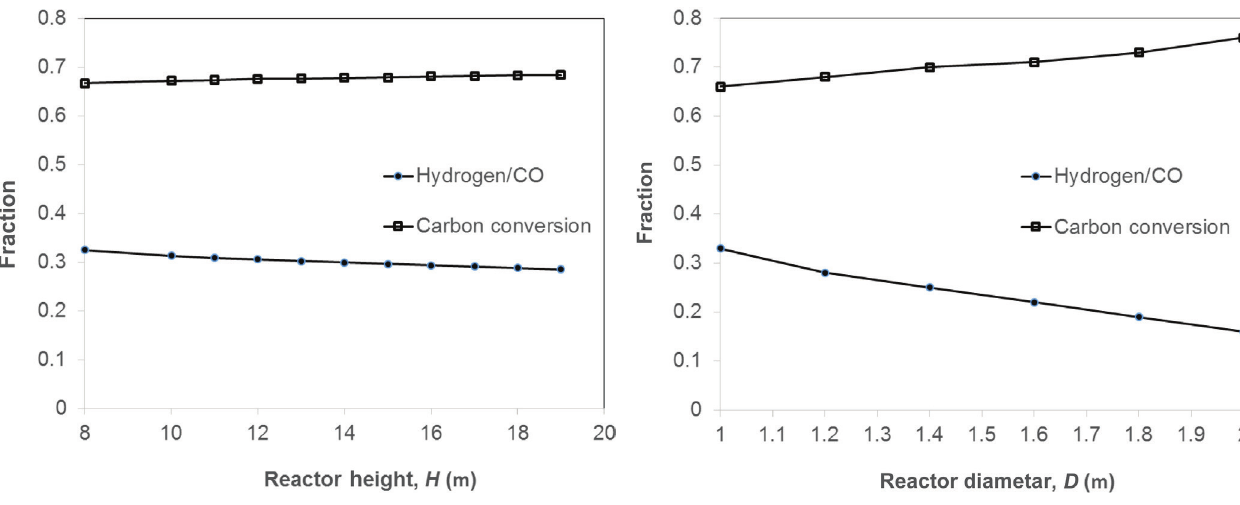
Fig. 5 – Effect of bed diameter on syngas quality and carbon conversion